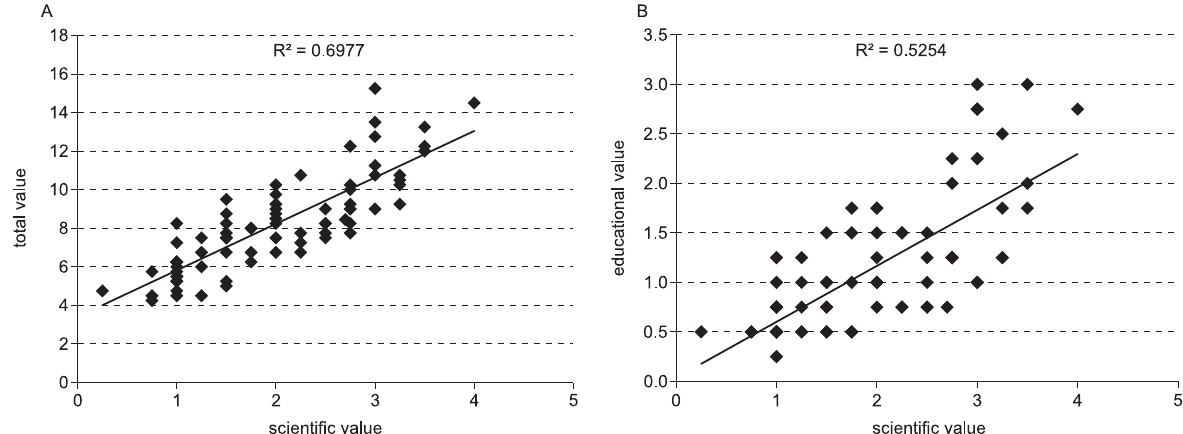
Fig. 3. Correlation between: A – the scientific value and the total value, B – the scientific value and the educational